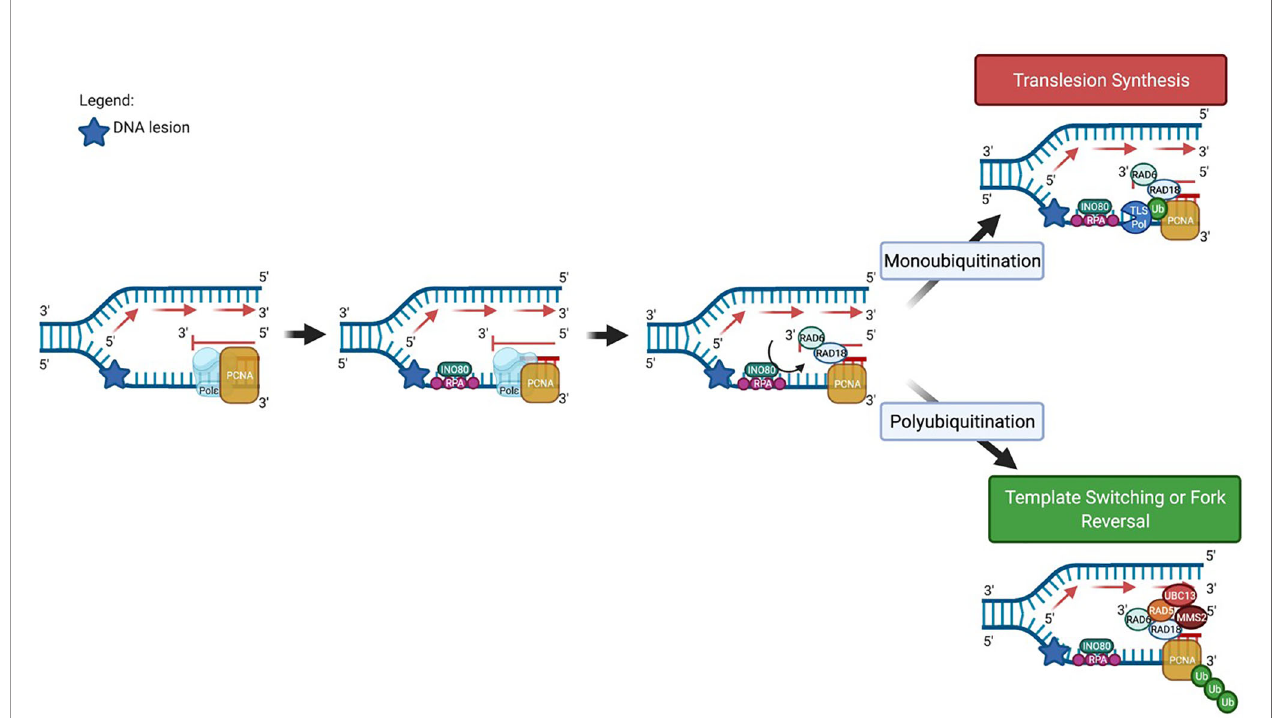
FIGURE 2 | Schematic diagram showing key proteins involved in the initial steps of DNA damage tolerance pathway activation at an arrested replication fork. PCNA, proliferating cell nuclear antigen; RPA, replication protein A; UBC13, Ubiquitin-conjugating enzyme E2 13; MMS2, Ubiquitin-conjugating enzyme variant MMS2. Image generated with